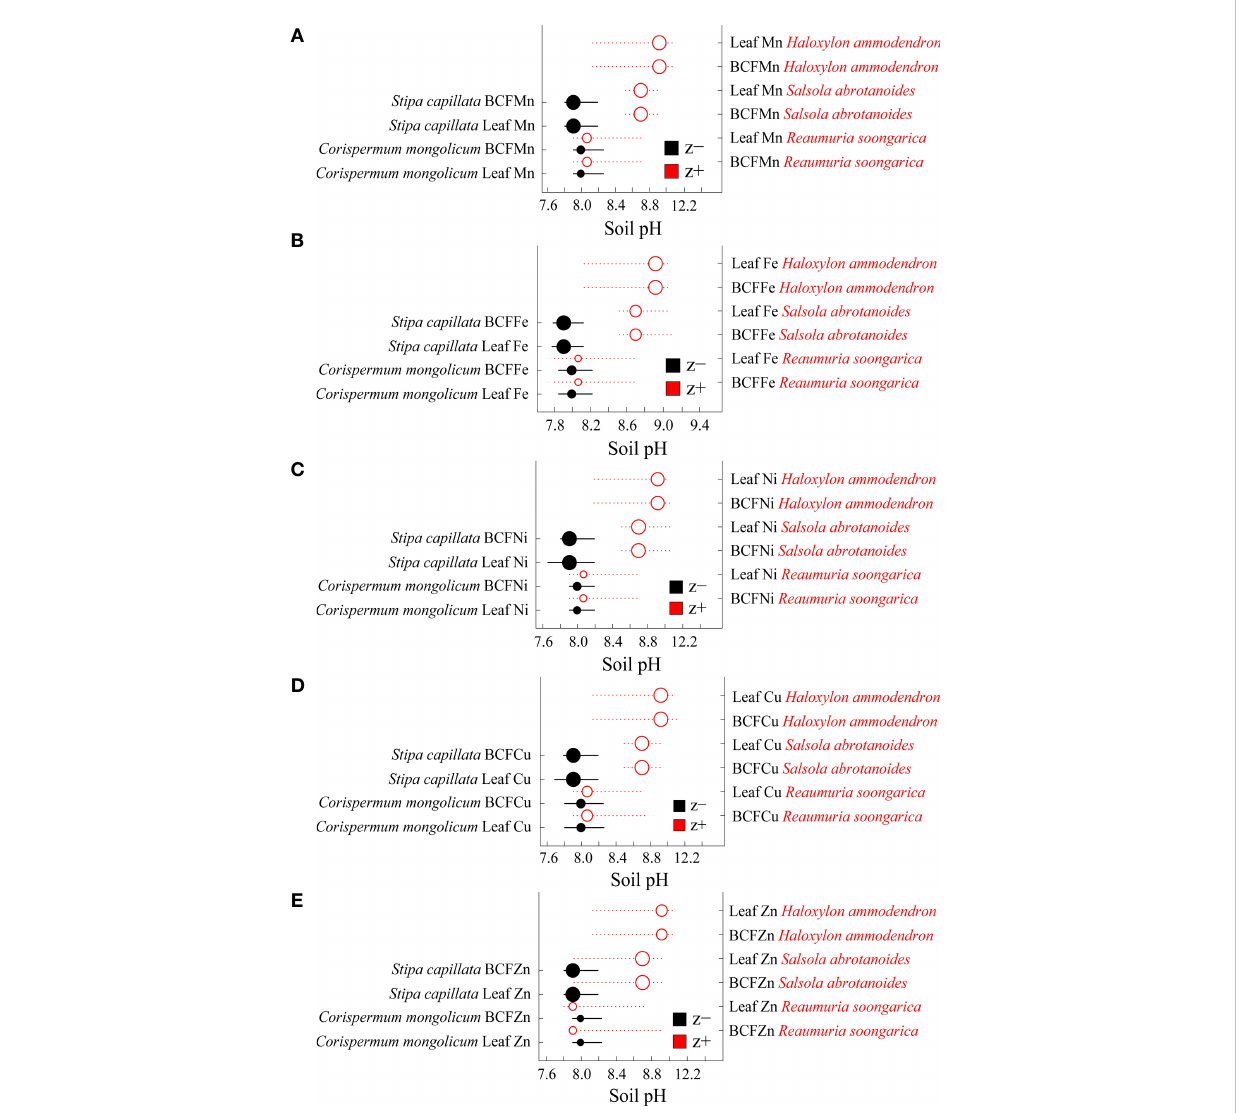
FIGURE 6 Threshold Indicator Taxa Analysis (TITAN) of leaf microelement concentrations and bioconcentration factors (BCFs) in response to soil pH. (A) Mn and the BCF of Mn, (B) Fe and the BCF of Fe, (C) Ni and the BCF of Ni, (D) Cu and the BCF of Cu and (E) Zn and the BCF of Zn. Black and red symbols represent accumulative negative (sum z-) and positive (sum z+) responses, respectively. Symbol size is in proportion to z scores (magnitude of response). Horizontal lines represent the 95% bootstrap con fi dence intervals. Woody and herbaceous species are shown in red and in black fonts,